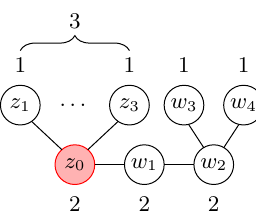
(3), P (2) g quiver with SU(2) 3 (cid:2) D 4 global symmetry, b = 1, dim M H [1 3 ] [1 2 ]